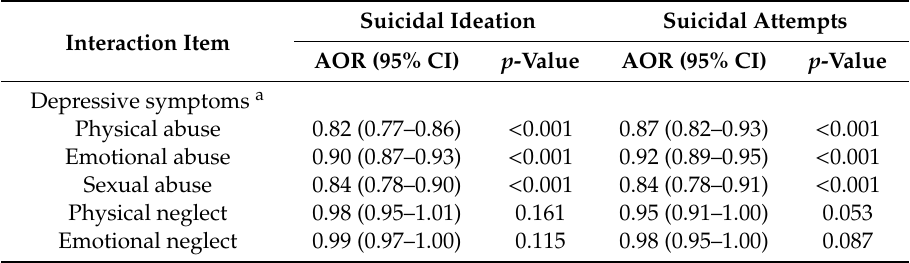
Table 3. Associations of interaction items with suicidal ideation and suicidal